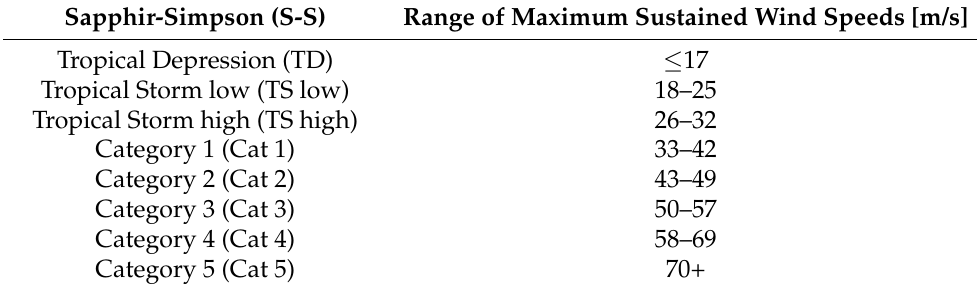
Table 1. Wind speed ranges within the Sapphir-Simpson hurricane intensity scale for classifying tropical cyclones